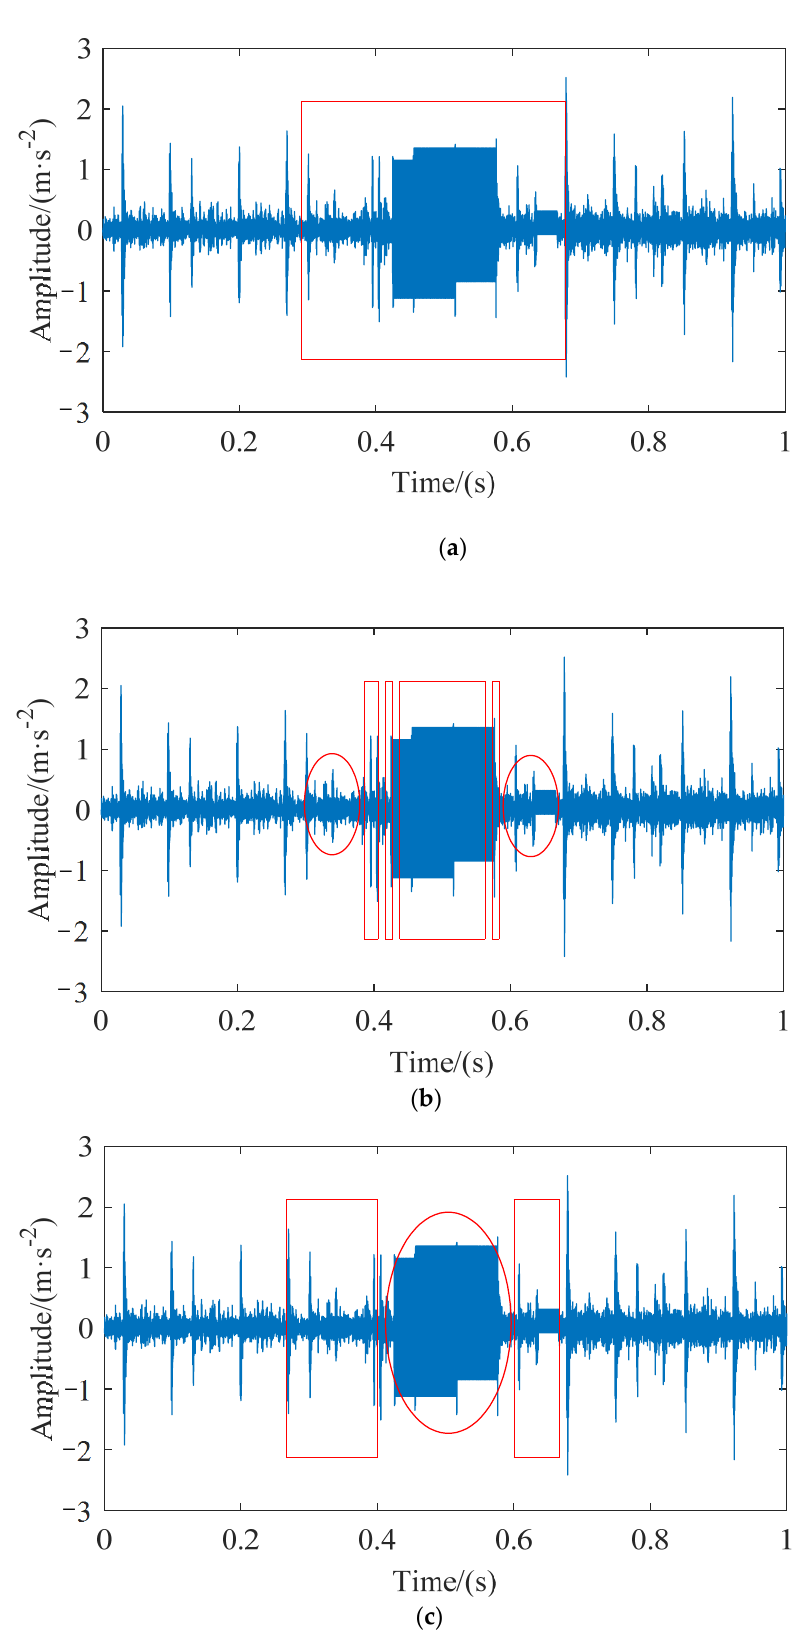
Figure 14. Abnormal data detection results of drive end signal. ( a ) CF-POIF; ( b ) CF-IF; ( c ) CF-LOF. The accuracy and